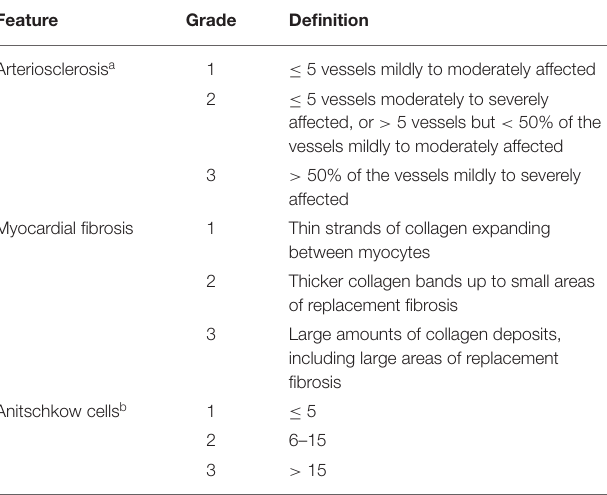
TABLE 1 | Semiquantitative scoring scheme for arteriosclerosis, myocardial fibrosis, and Anitschkow cell presence in histological sections of the heart of six Eurasian lynx (subspecies Lynx lynx carpathicus ) from Switzerland affected by